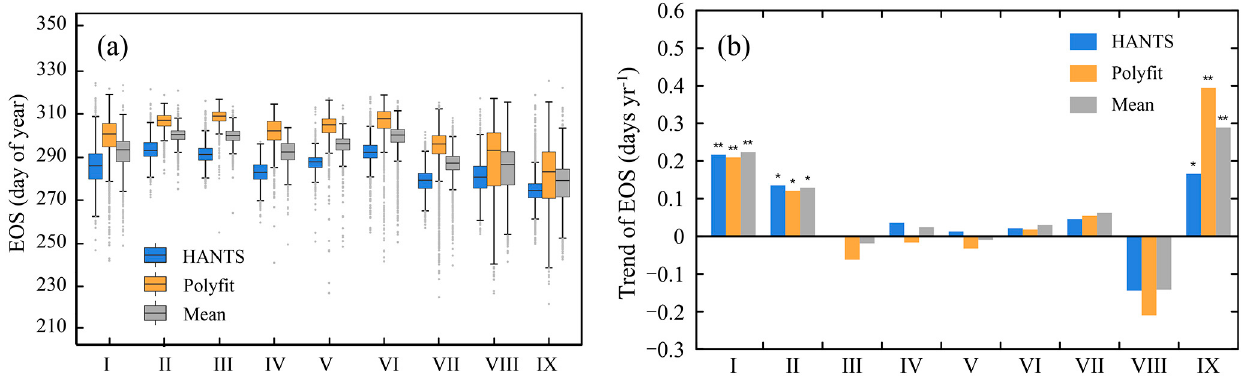
Figure 3. Bar graphs of the ( a ) mean EOS values and ( b ) their trends. “**” indicates p < 0.01 and “*” indicates p < 0.05.